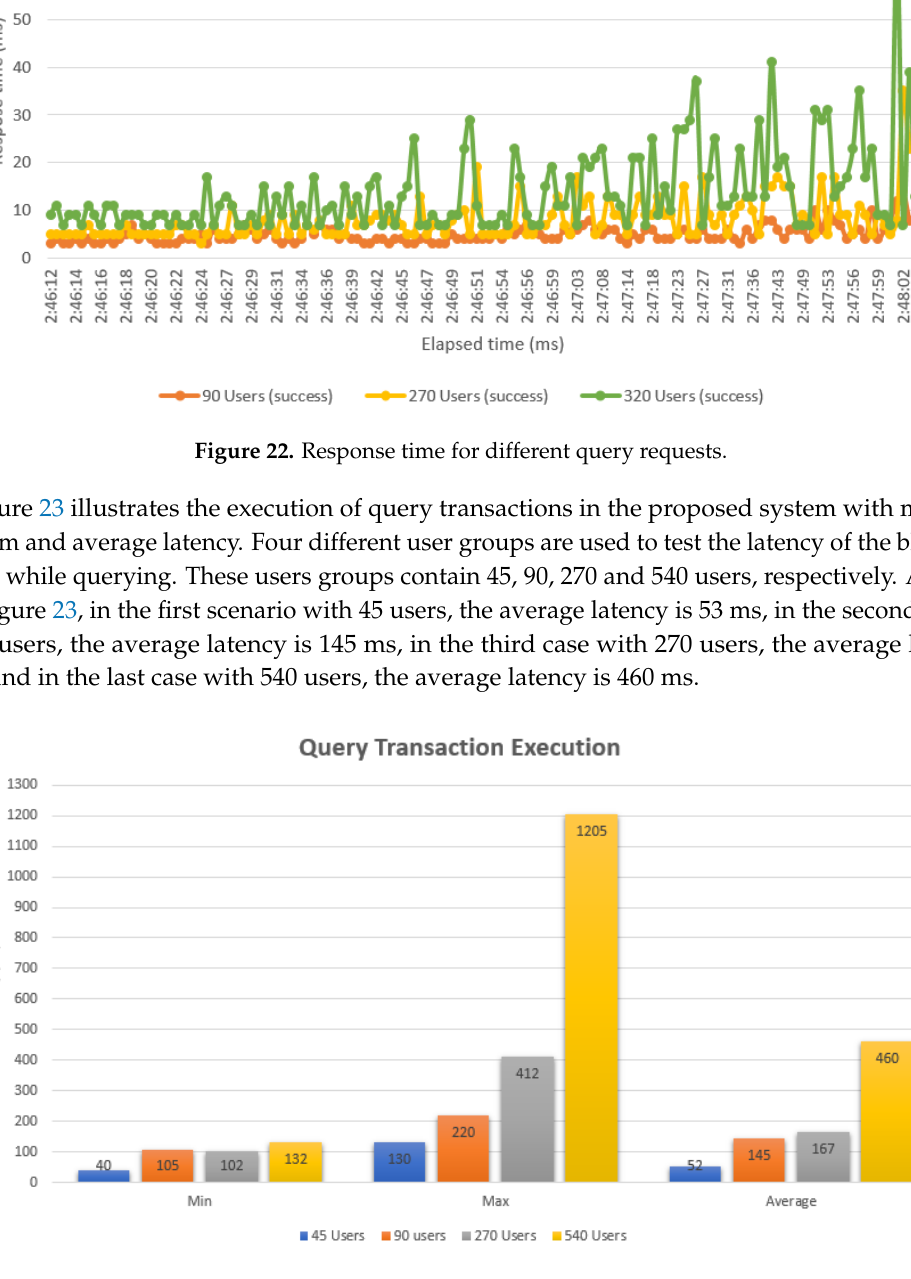
Figure 23. Latency in query